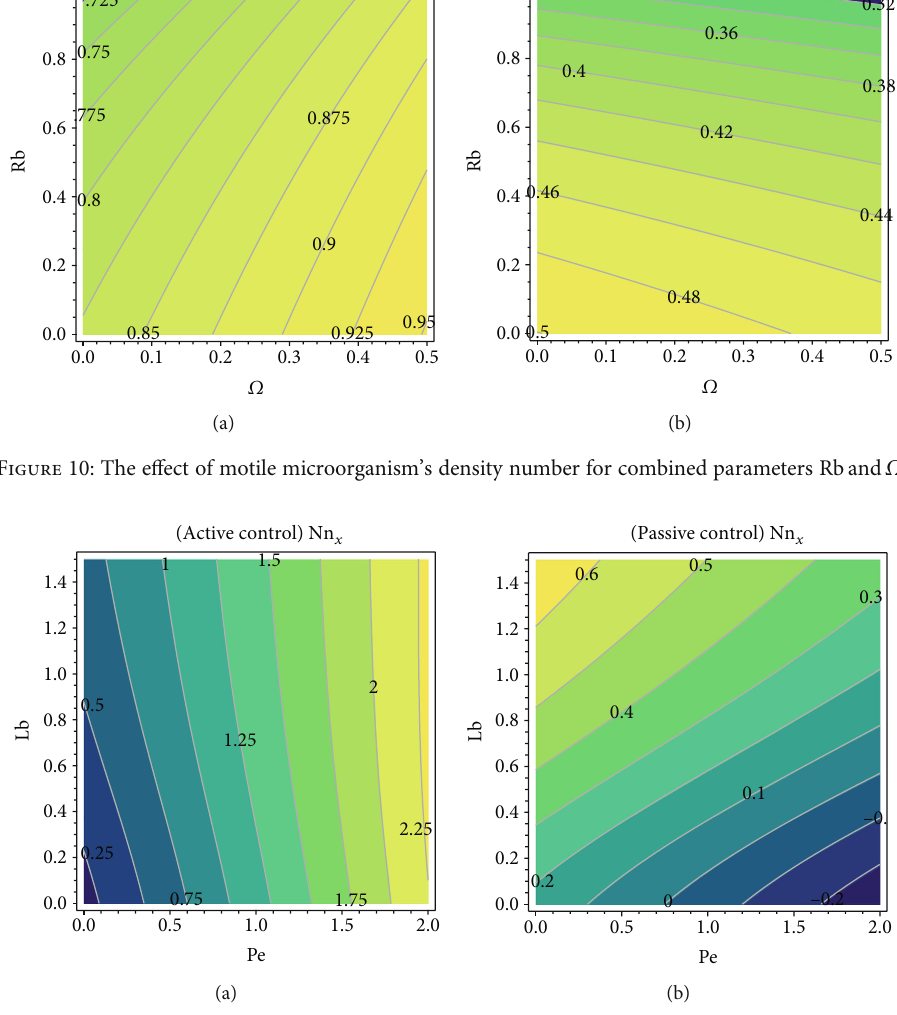
Figure 11: The e ff ect of motile microorganism ’ s density number for combined parameters LbandPe .